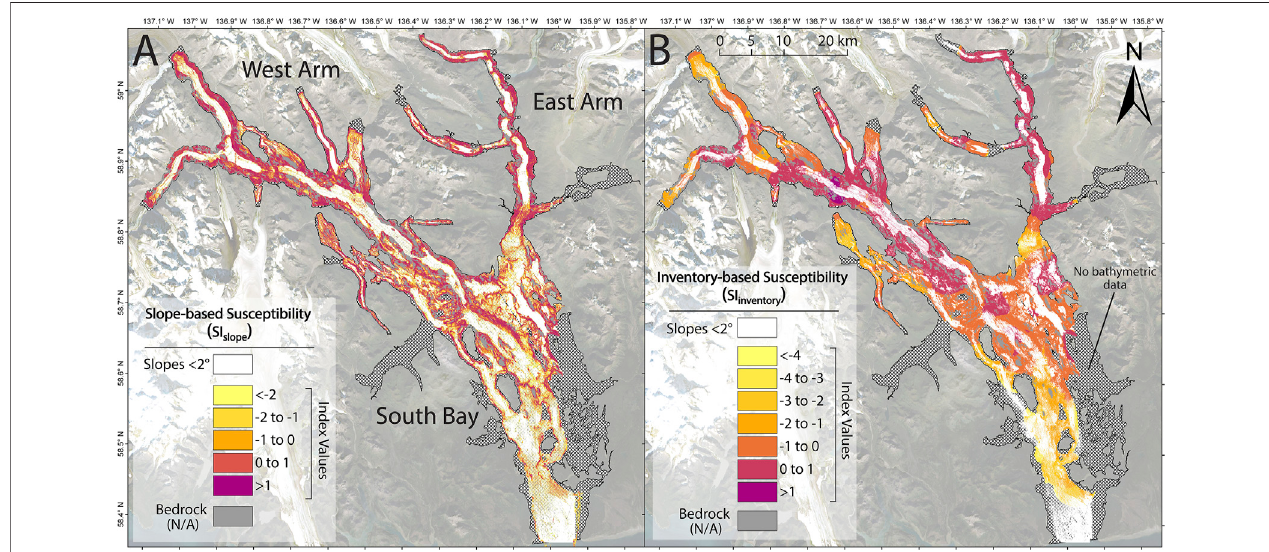
FIGURE 10 | (A) Map of slope-based susceptibility for Glacier Bay using SI slope values shown in Figure 8E . (B) Map of inventory-based susceptibility for Glacier BayusingSI inventory valuesderivedasthelog-normalratioofexpectedlandslideaccumulation(based ontheregressionin Figure9D )toactuallandslideconcentration in a 3-km radius moving window ( Figure 3B ).